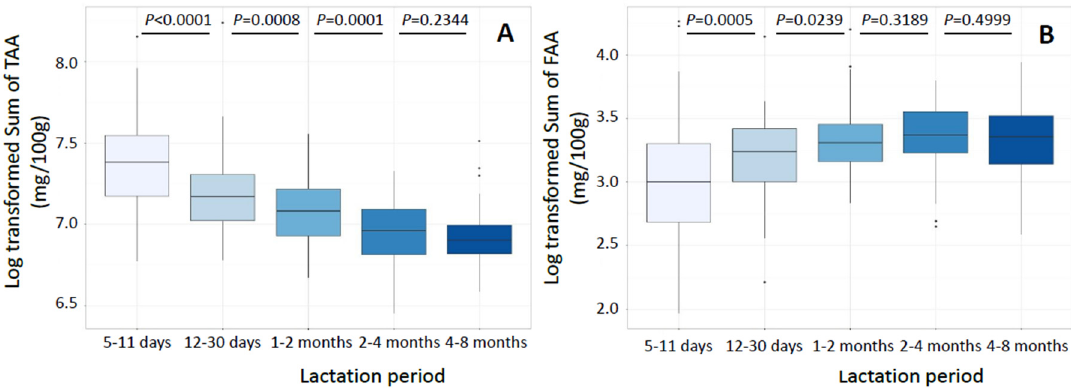
Figure 2. Box plot of the log-transformed sum of total (TAA, ( A )) and of free (FAA, ( B )) amino acids in milk from the different lactation periods. n = 90 milk samples per lactation period. Statistically significant differences between two periods were set at p < 0.05.